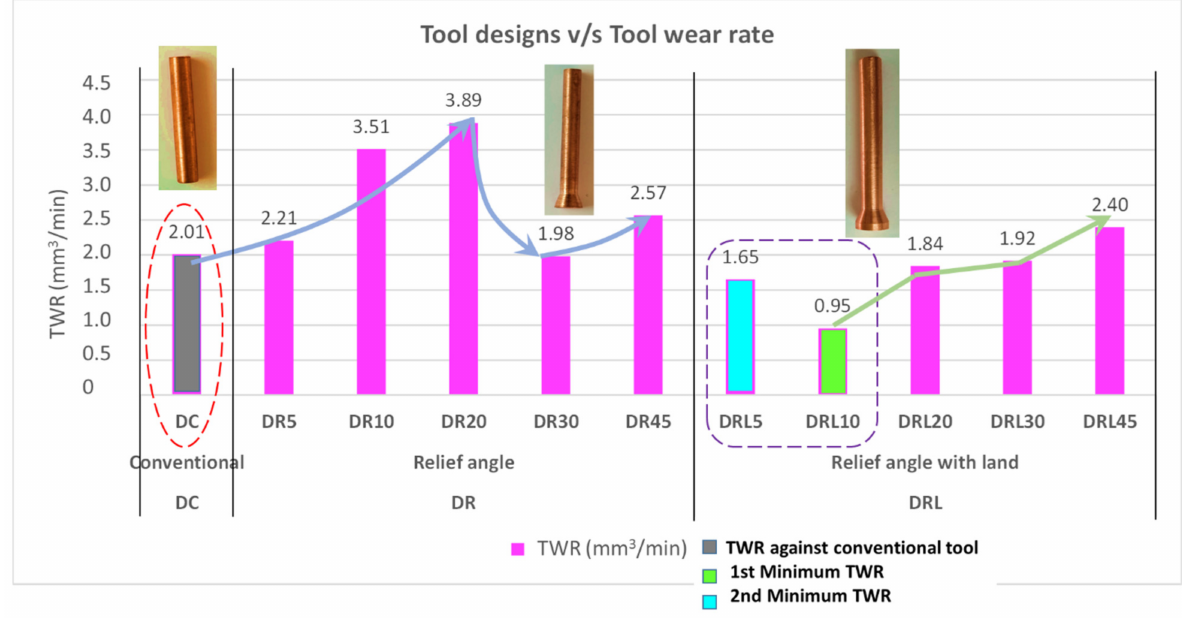
Figure 10. Comparison of tool wear rate (TWR) under the use of different electrode designs.